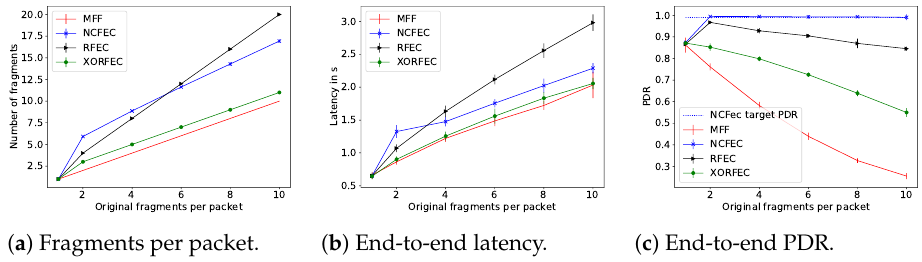
Figure 16. Simulation results for linear topology with link quality of 0.65.